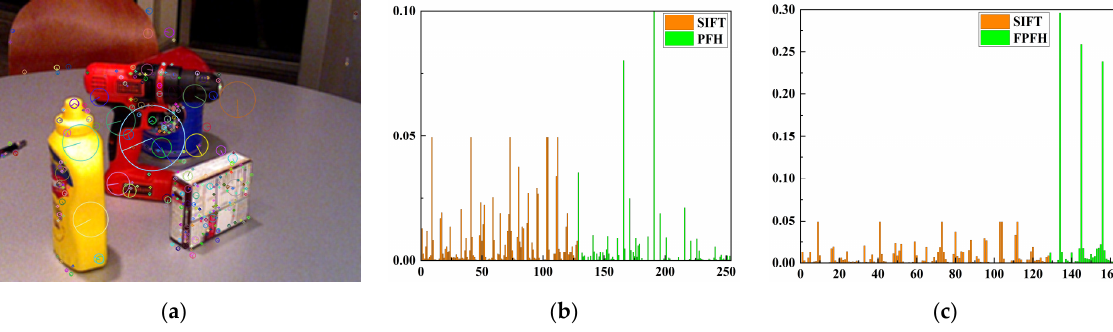
Figure 8. An example of an RGB-D image in the YCB dataset. ( a ) RGB image; ( b ) depth image.